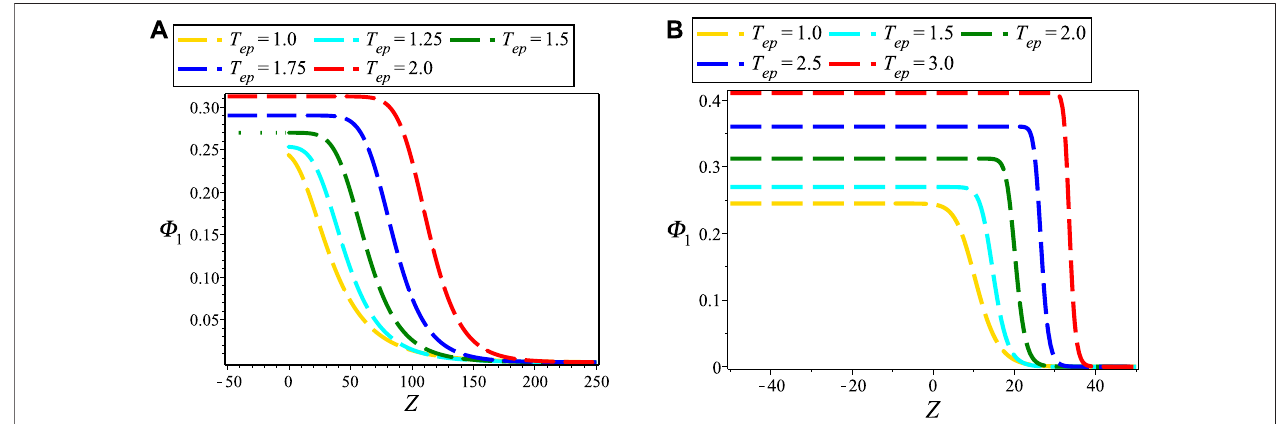
FIGURE4| ElectrostaticNIASWEsfordifferentof (A) T ep with d (cid:2) 1, r (cid:2) e , β (cid:2) 0.9, α e (cid:2) 0.5, ρ 0 (cid:2) 0.96, T ep (cid:2) 1, V i 0 / c (cid:2) 0.1, N p 0 / N e 0 (cid:2) 0.5and T (cid:2) 100;and (B) T ep with the same typical values of (A) except β (cid:2) 1.